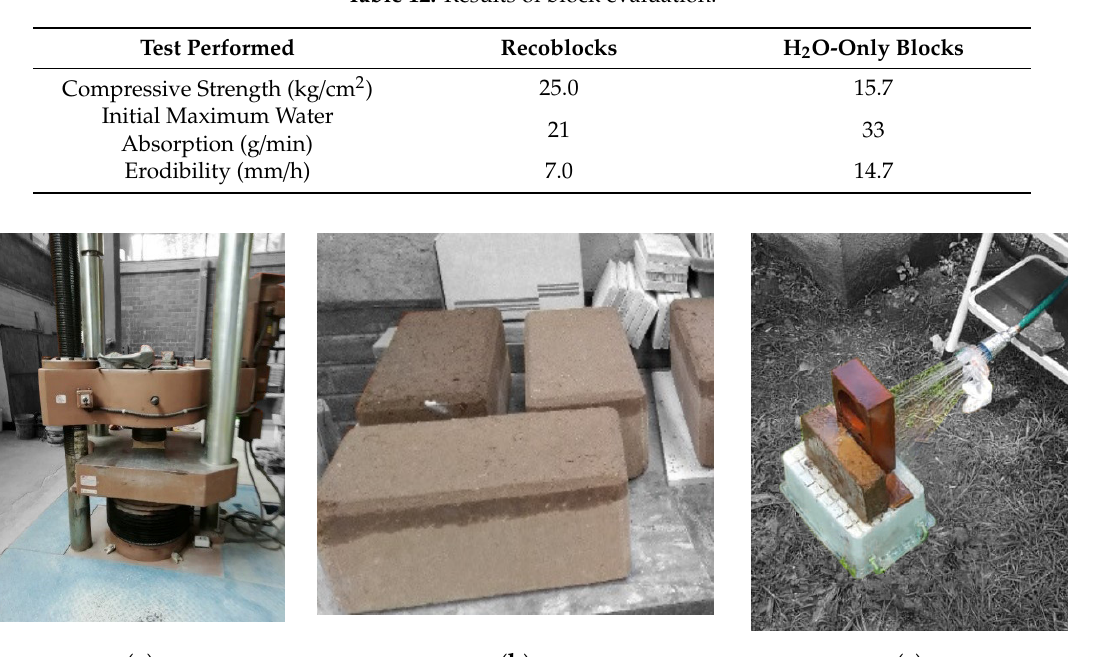
Table 12. Results of block evaluation .